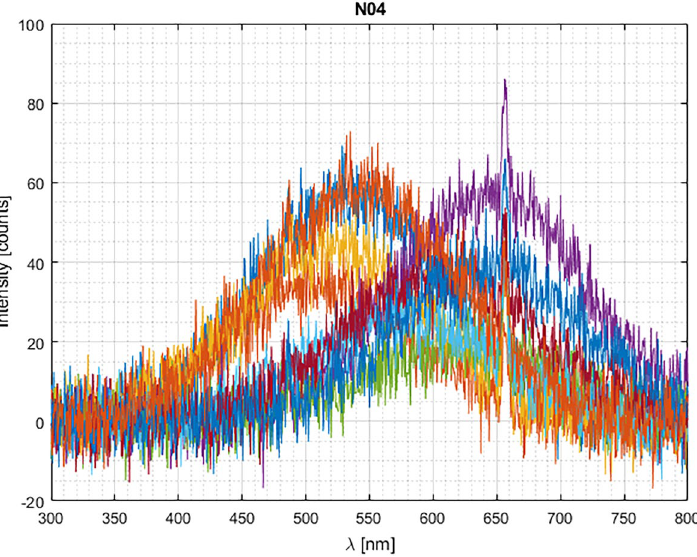
Figure 2. Example of spectra in the N04 dataset, showing spectra calculated with agent concentrations ranging from 0.1 and 0.15. The image aims to show in what extreme conditions the algorithm has been tested.